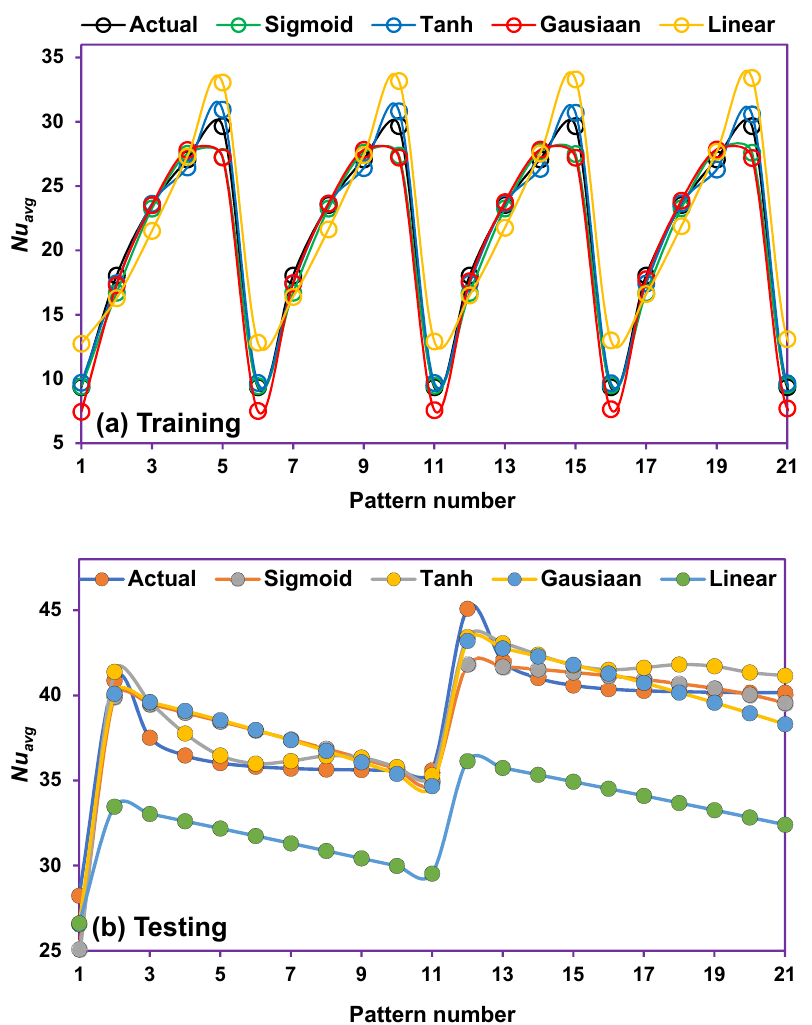
Figure 9. The trend of battery Nu avg data for the selected pattern (data points) was obtained from ( a )